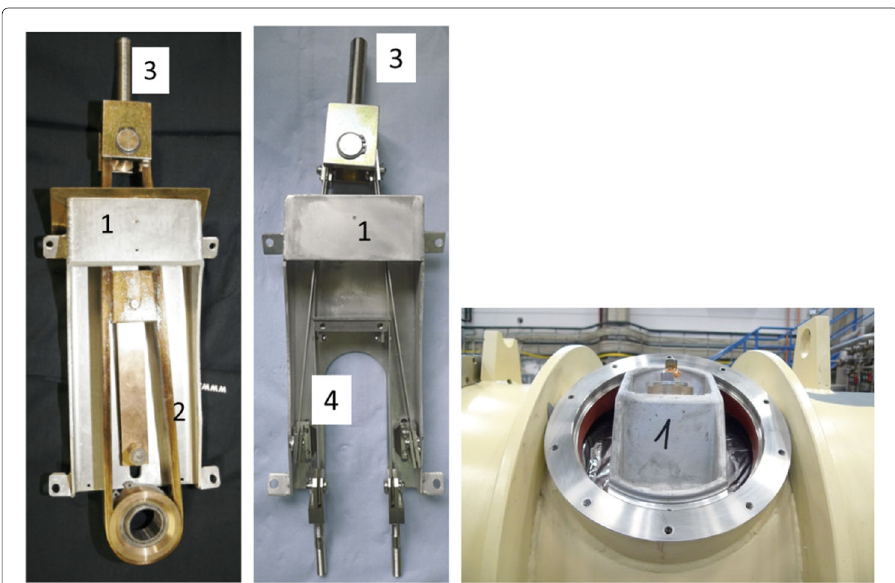
Fig. 18 Left: Original suspension of the cold mass removed from the cryostat. The suspension with the radiation shield box (1) prevented the installation of a pressure prop into the cryostat (see text). Middle: The new suspension, with a slit machined into the radiation shield box and Titanium strips replacing the G10 loop, allowed to slide the suspension over the installed pressure prop. 1: Radiation shield box, 2: G10 supporting loop, 3: Suspension screw, 4: Titanium support strips. Right: Suspension screw at top of the